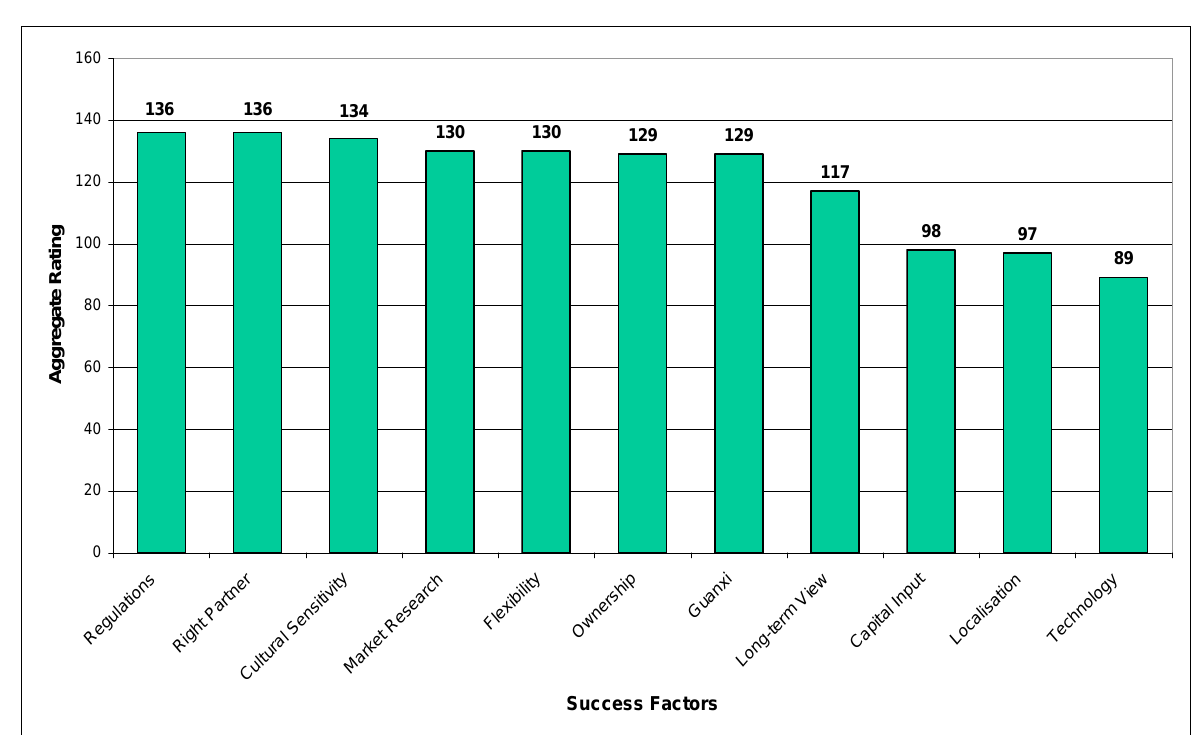
Figure 1: Performance success factors and aggregate